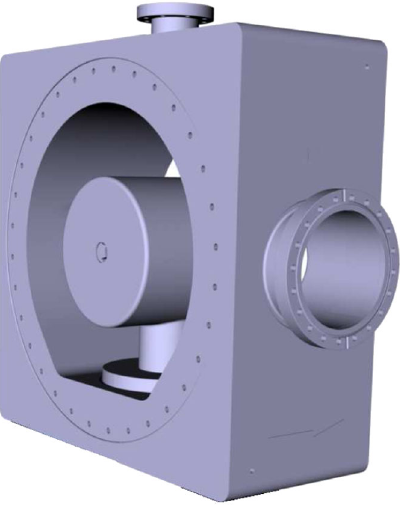
injector.FIG. 49. A 3D view of the coupling section between two coupled CH